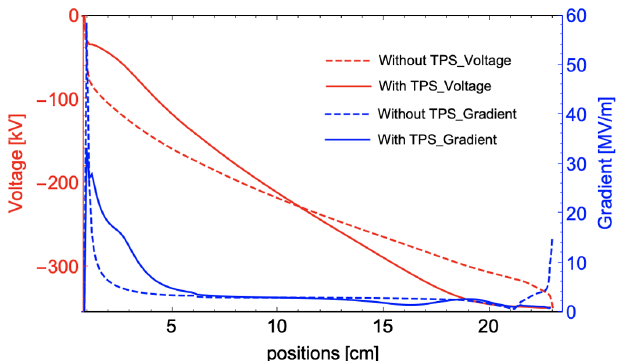
FIG. 4. The potential and gradient along the ceramic feed- through, comparison between with and without triple-point shields (TPS). The position 0 cm is the ground side of the feedthrough, toward the 24 cm of high voltage electrode